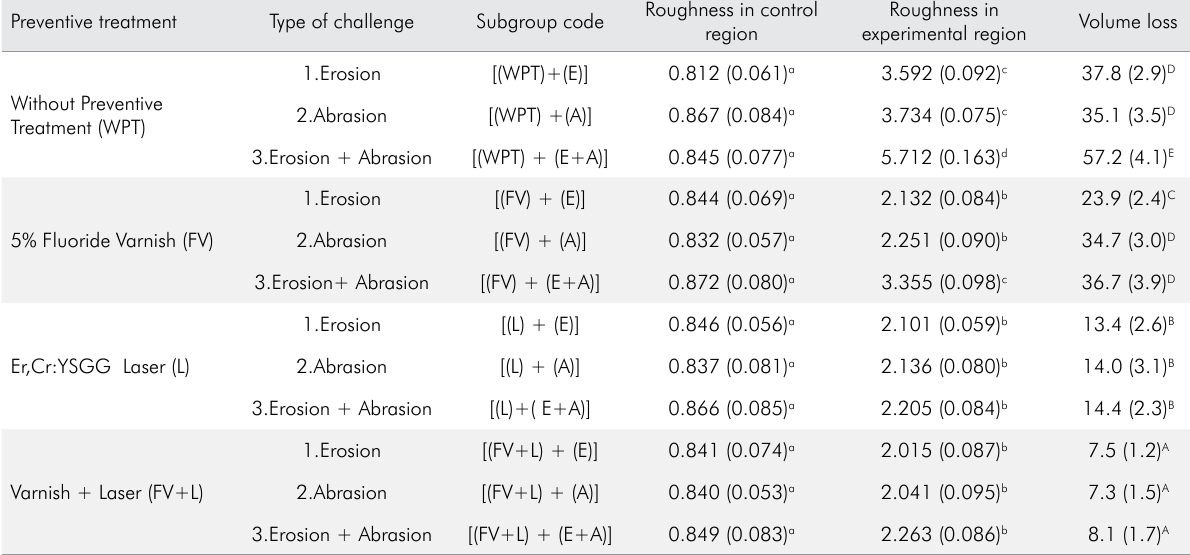
Table. Mean values and standard deviation of the surface roughness ( μ m²) and volume loss (%) of the groups, considering the control and experimental